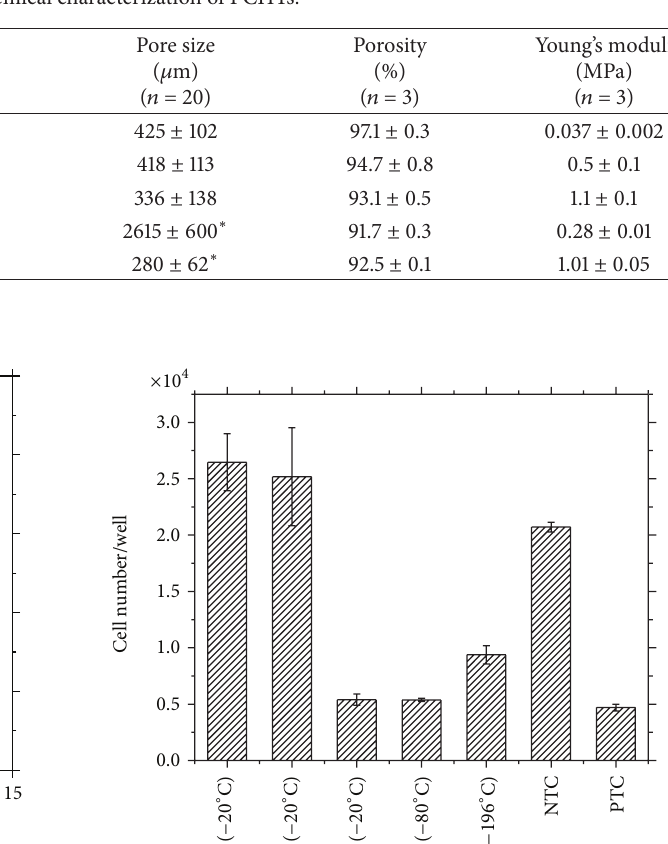
Table 1: Physicochemical characterization of PCHTs.